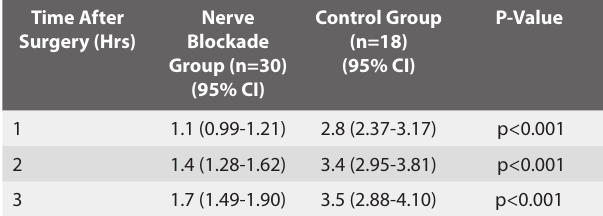
Table 2. Postoperative pain scores in both groups* Comparison of pain levels 1-3 hours postoperatively in nerve blockade intervention group with control group.